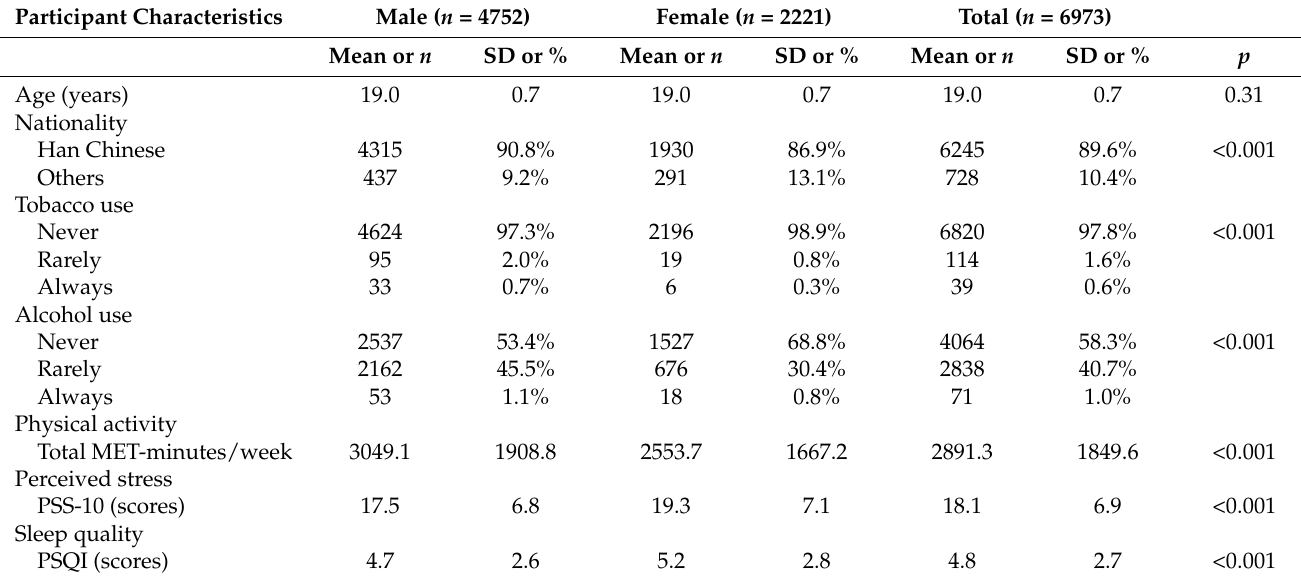
Table 1. Demographic and characteristics of participating students in the